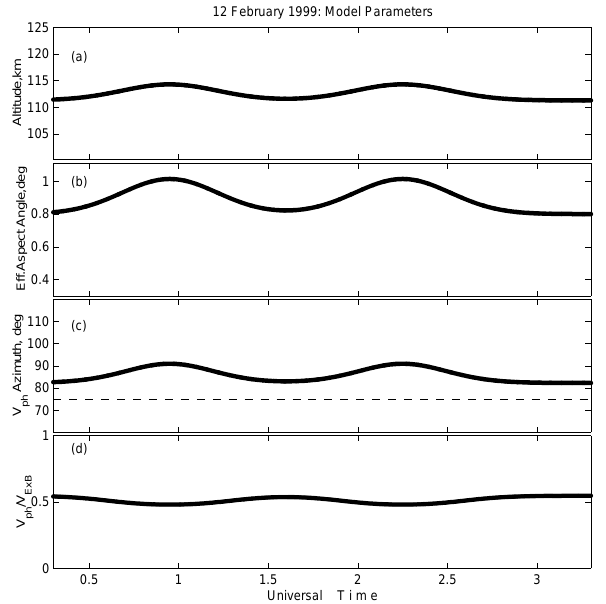
Figure 6: Uspensky et Fig. 6. The off-orthogonal fluid approach modelling: (a) the effec- tive backscatter altitude, (b) the effective aspect angle, (c) the az- imuth of the largest irregularity phase velocity V ph , blue line, and the mean V E × B azimuth of 75 ◦ , dashed line, and (d) the predicted | V ph | / | V E × B | velocity